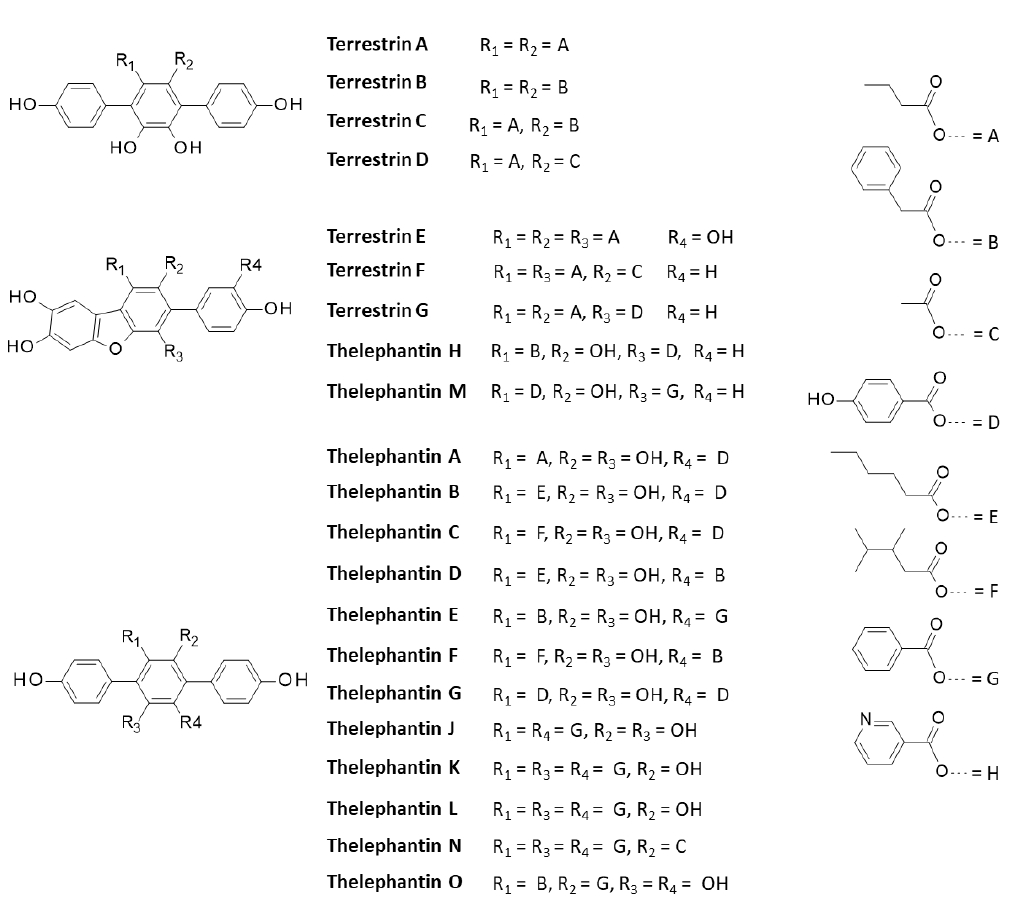
Figure 4. Structures of terrestrins A-G and telephantins A-O. For clarity, the quinone derivative telephantin I is not presented here (it can be found in [33]).